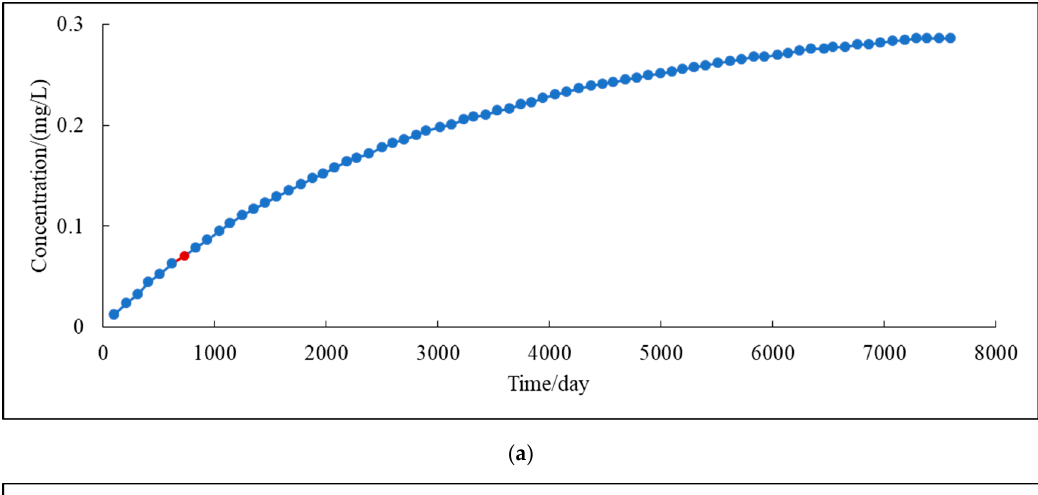
Figure 13. Simulation results of migration of the ammonia pollution plume in the four sections.( a ) Simulation results of plane migration of ammonia pollution ( b ) Simulation results of plane migration of ammonia pollution ( c ) Simulation re- sults of plane migration of ammonia pollution ( d ) Simulation results of plane migration of ammonia pollution.